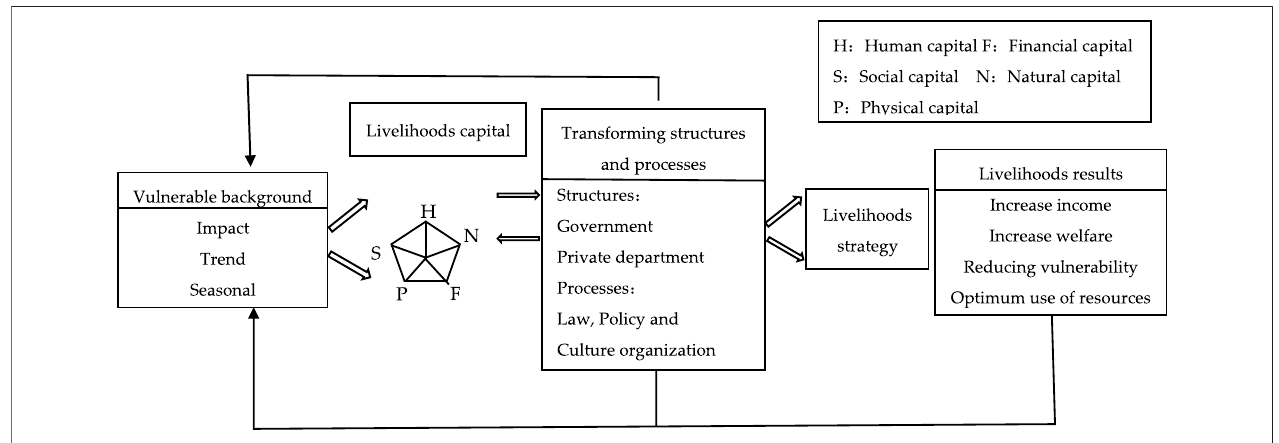
FIGURE 1 | Sustainable livelihoods